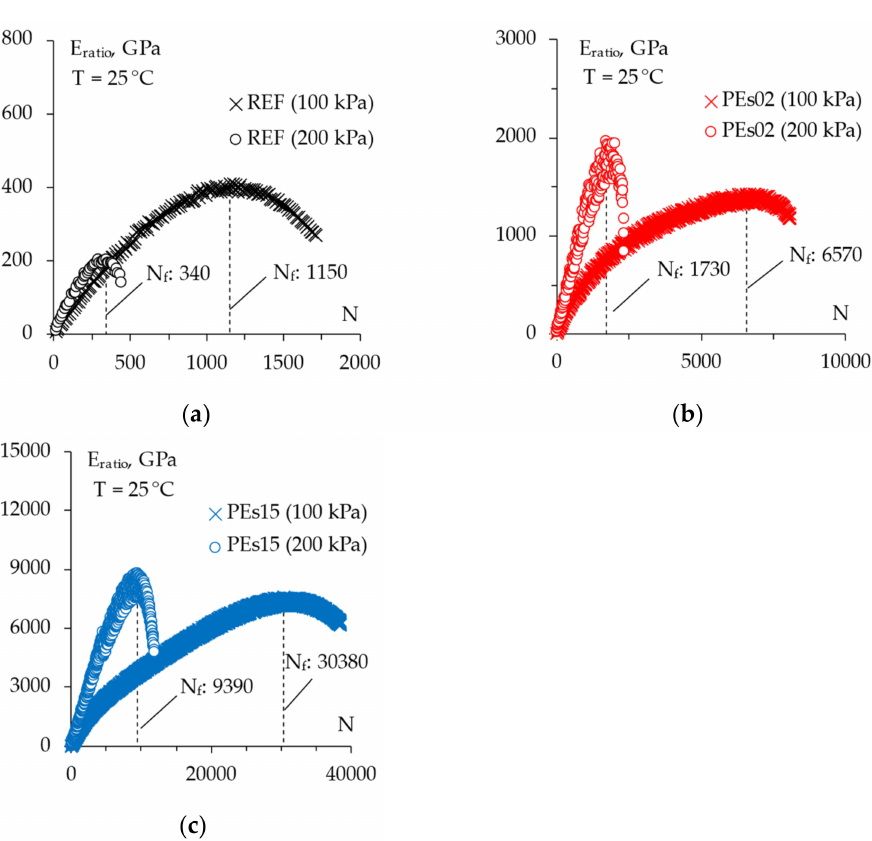
Figure 18. The ITF test energy ratio for the tested mixtures: ( a ) REF; ( b ) PEs02; ( c )